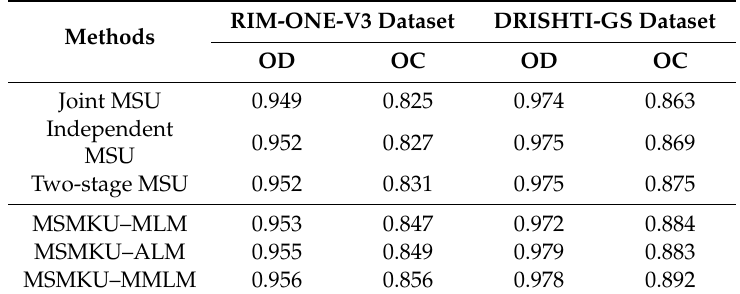
Table 4. F -score comparisons of di ff erent training strategies for OD and OC